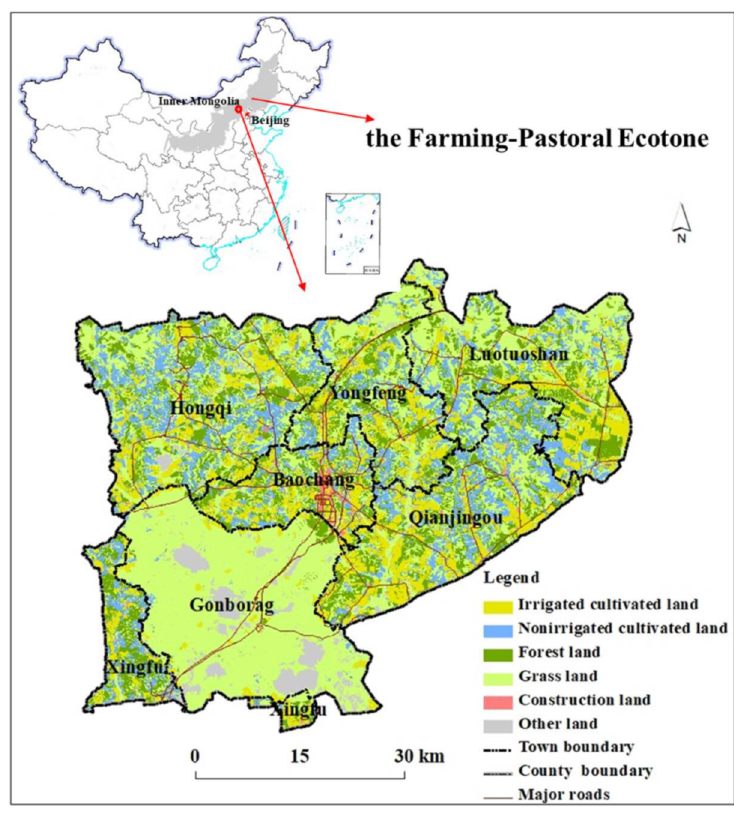
Figure 2. The location of